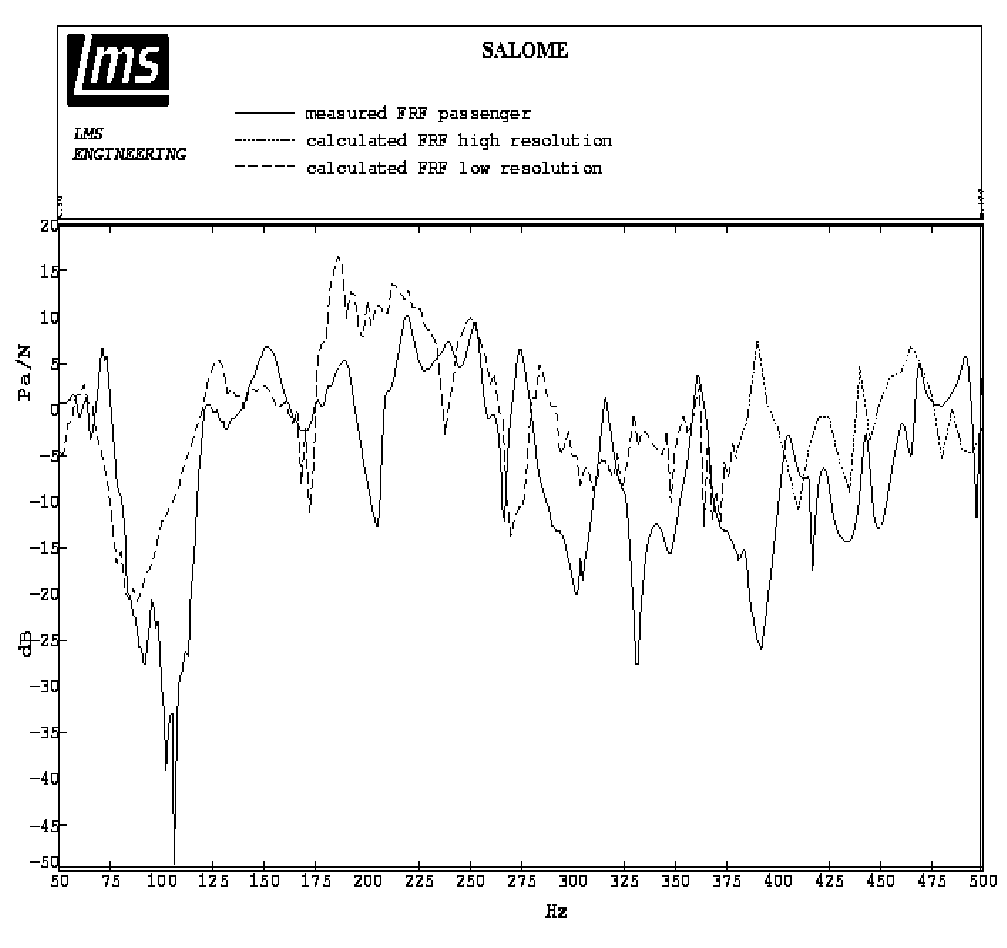
Fig. 16. Calculated versus measured pressure with respect to unity force at the